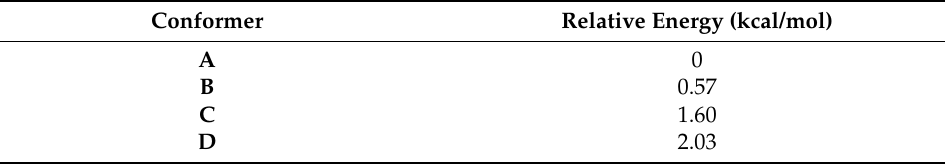
Figure 6. Potential energy scan of I8 derivative. Table 2. Relative stability of possible configurations for I8 derivative.